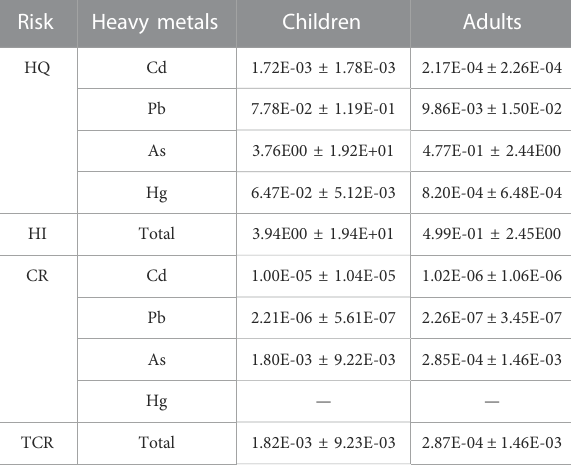
TABLE 3 Carcinogenic risk and non-carcinogenic hazard quotient of four typical heavy